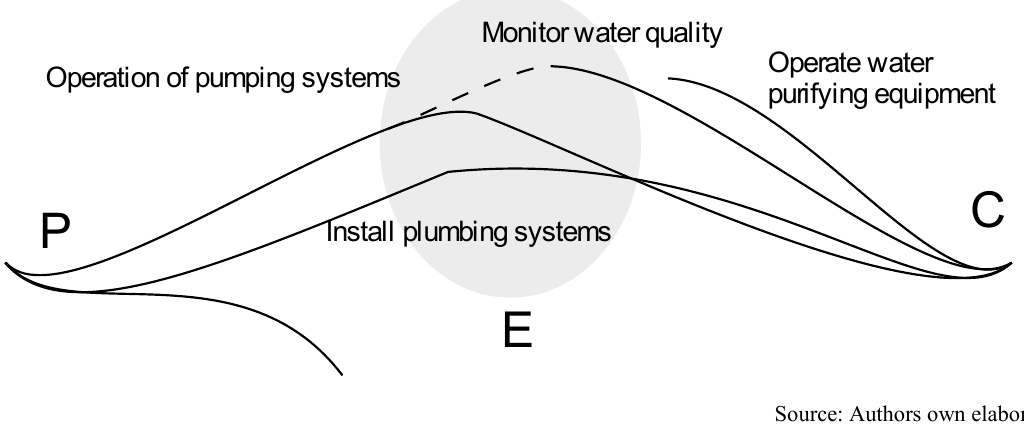
Source: Authors own